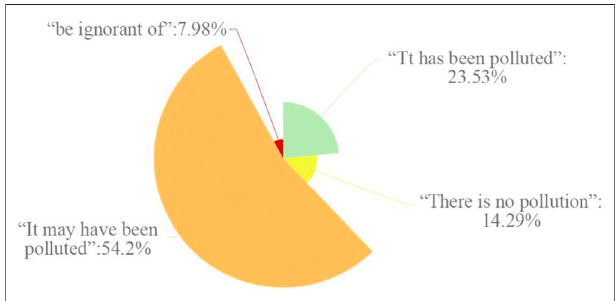
FIGURE3| Peasanthouseholds ’ cognitionofnon-pointsourcepollution of cultivated land.